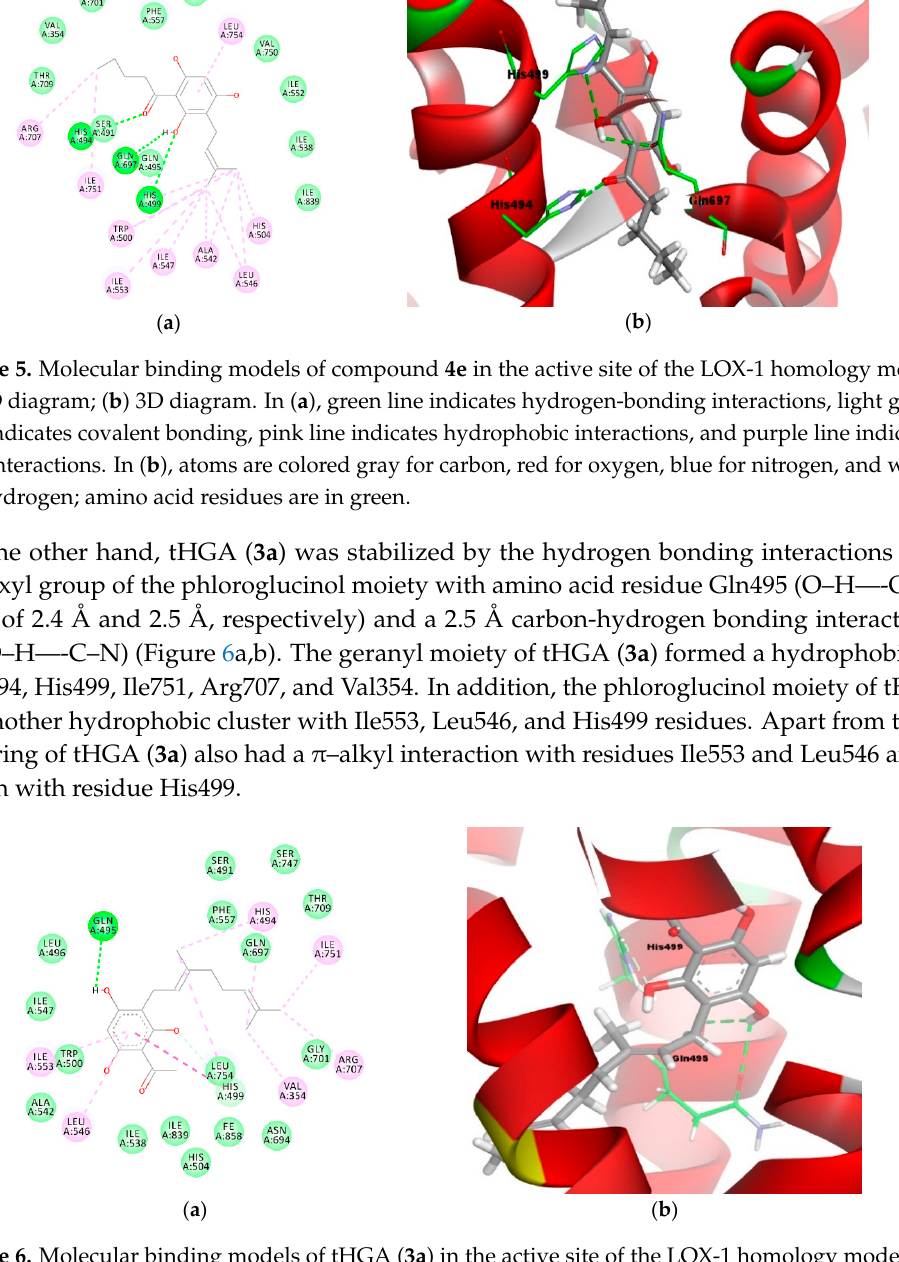
Figure 6. Molecular binding models of tHGA ( 3a ) in the active site of the LOX-1 homology model: ( a ) 2D diagram; ( b ) 3D diagram. In ( a ), green line indicates hydrogen-bonding interactions, light green line indicates covalent bonding, pink line indicates hydrophobic interactions, and purple line indicates π – π interactions. In ( b ), atoms are colored gray for carbon, red for oxygen, blue for nitrogen, and white for hydrogen; amino acid residues are in green.